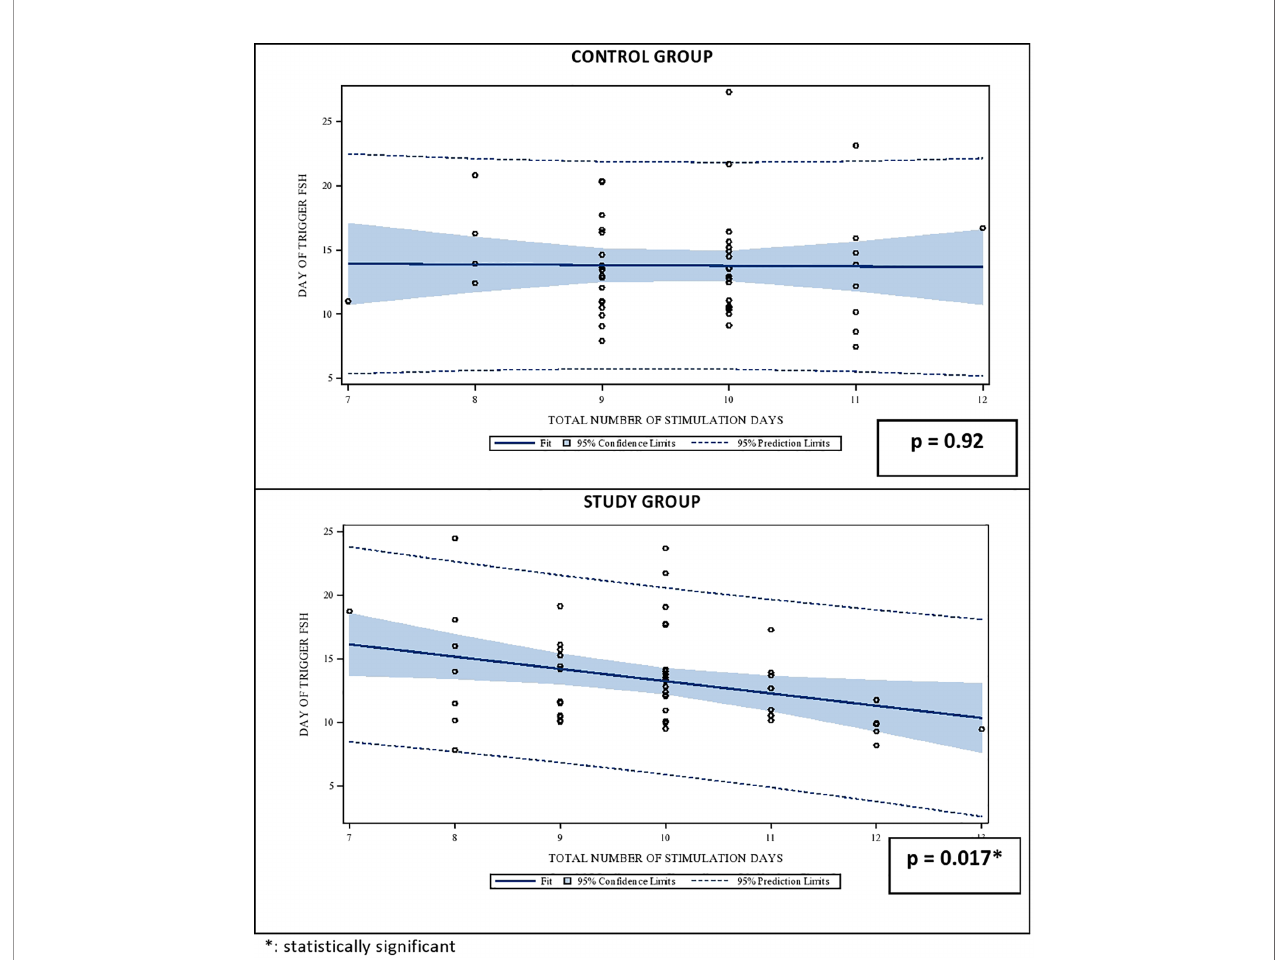
FIGURE 1 | Univariate regression analysis between the number of stimulation days and the median serum FSH level on day of trigger (DoT). FSH, Follicle Stimulating